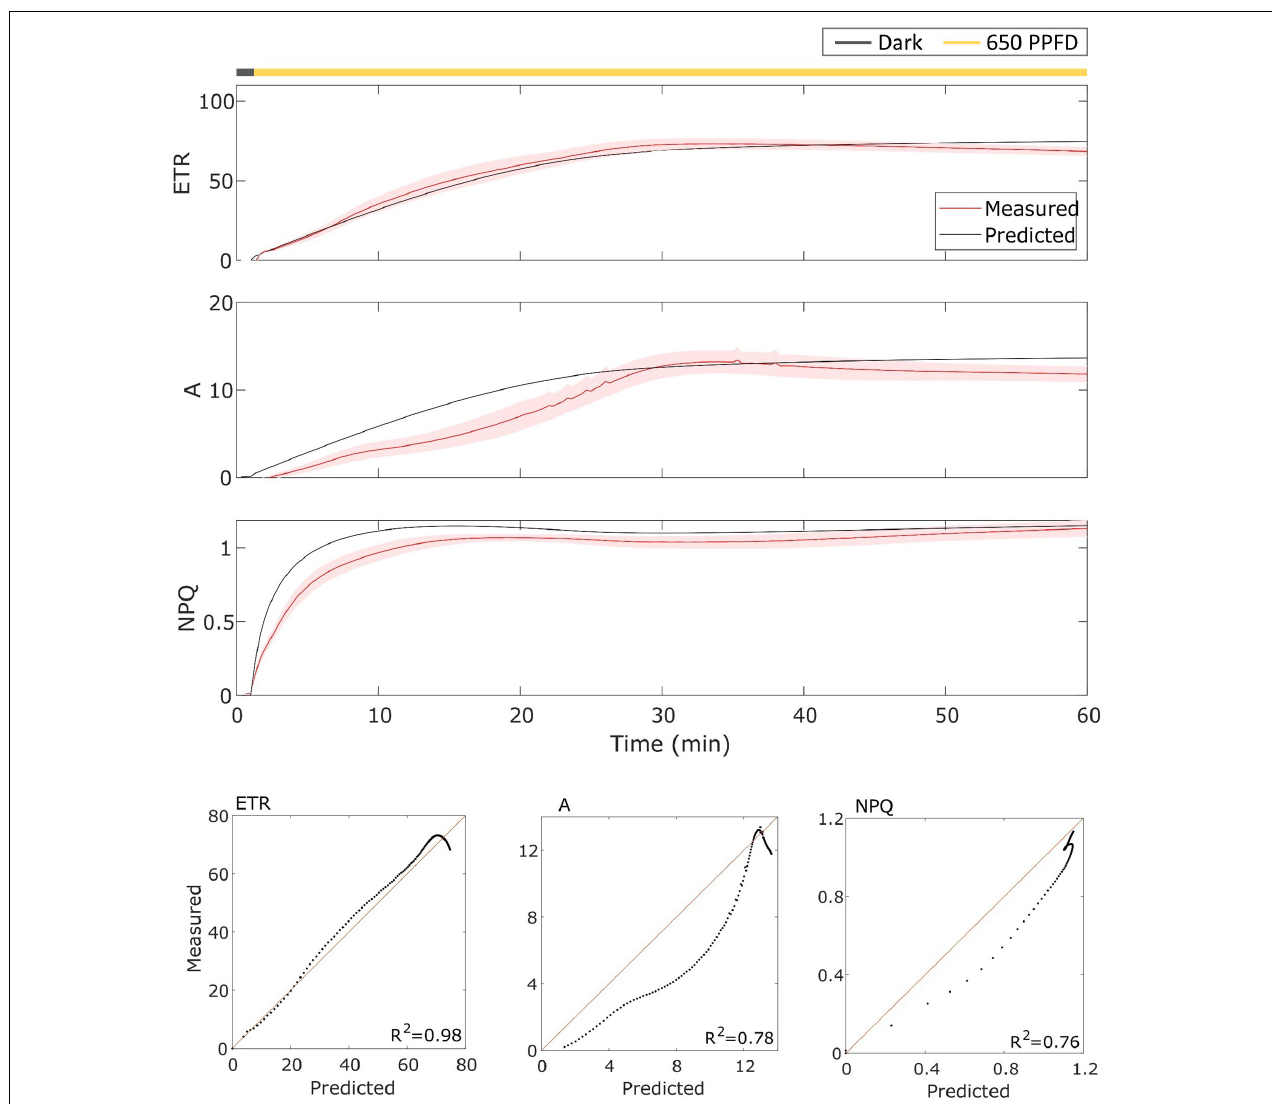
FIGURE 6 | (Top) MinnGold data (indicated in red) compared with model results (indicated in black) in constant light. The data are shown as means of three replicates (indicated as a red continuous line) and their standard error (indicated as the red shaded area around the mean value). (Bottom) Parity plots for ETR, A , and NPQ with related R 2